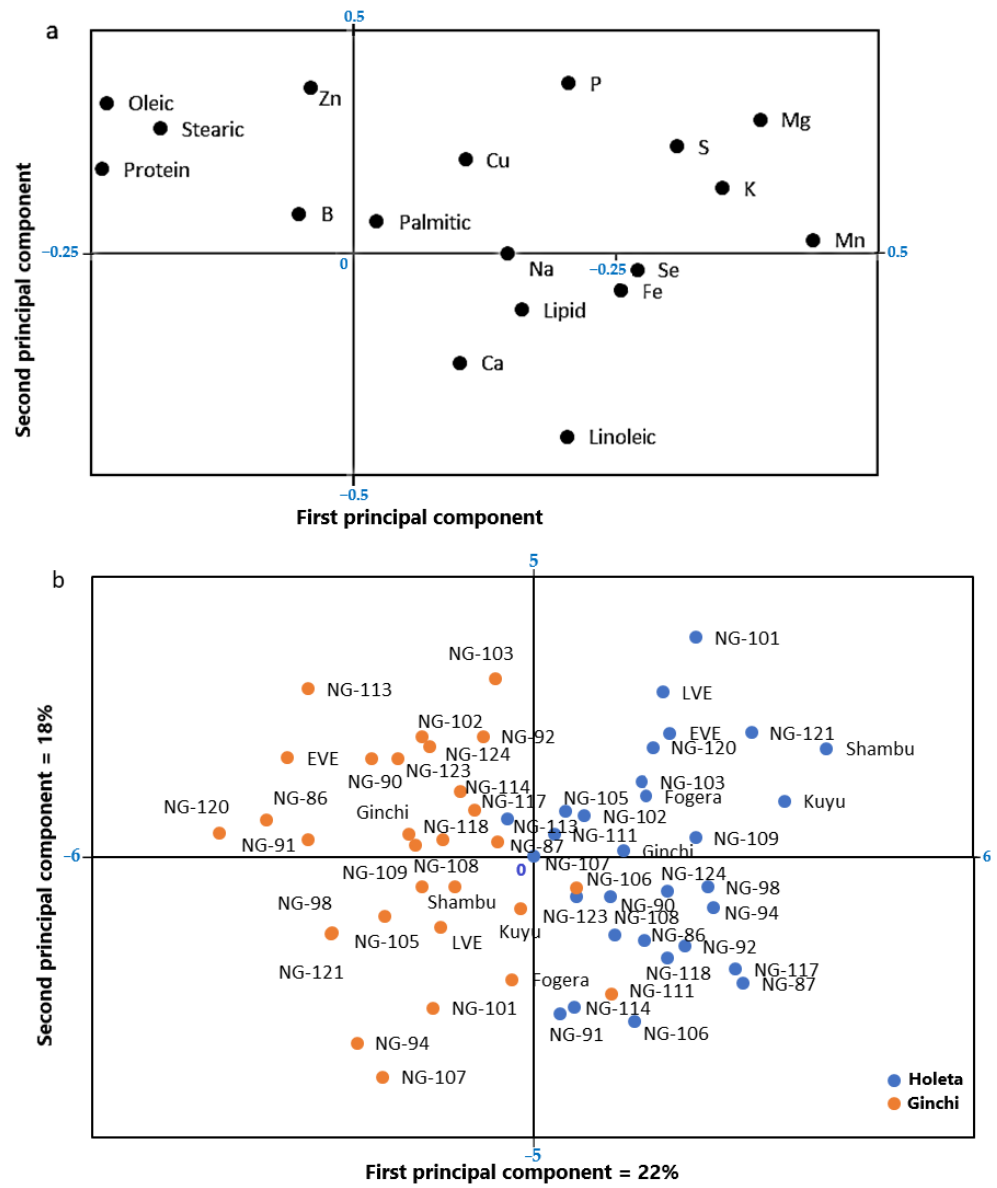
Figure 3. Loading ( a ) and score ( b ) plots from the principal component analysis of the total lipid, fatty acid, seed protein, and mineral contents of noug genotypes grown at two locations (Holeta and Ginchi).